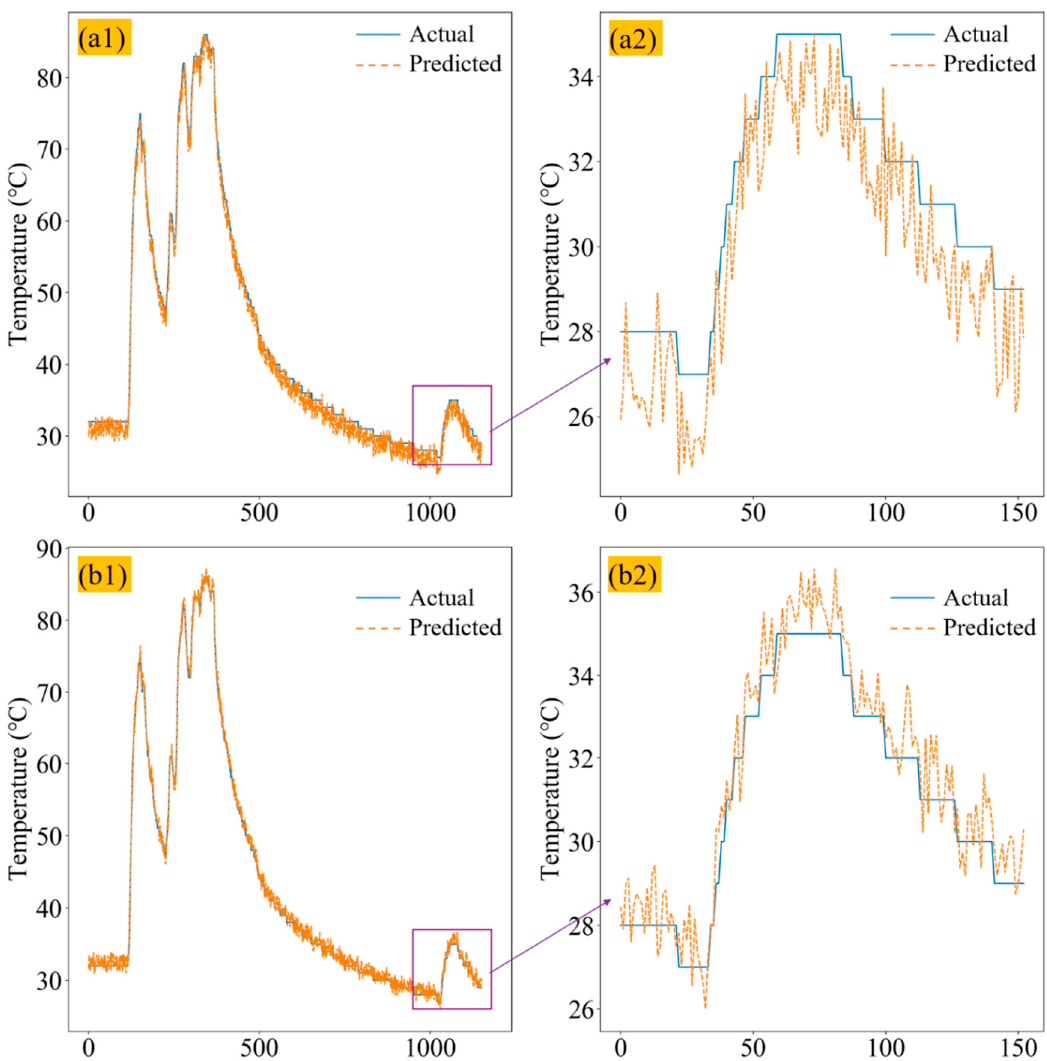
Figure 6. ( a1 ) One-layer LSTM predicted axle box bearing temperature and actual axle box bearing temperature comparison curves. ( b1 ) Two-layer LSTM actual axle box bearing temperature and actual axle box bearing temperature comparison curves. ( a2 ) and ( b2 ) are their local enlarged drawings.